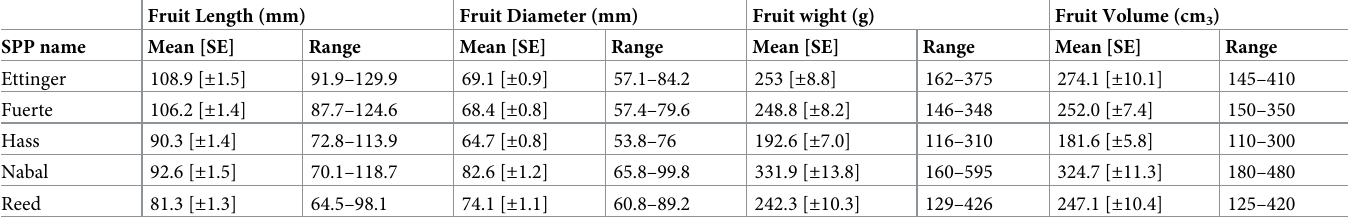
Table 1. Summary of volume, and fruit size characteristics of five avocado cultivars. Fruit Length